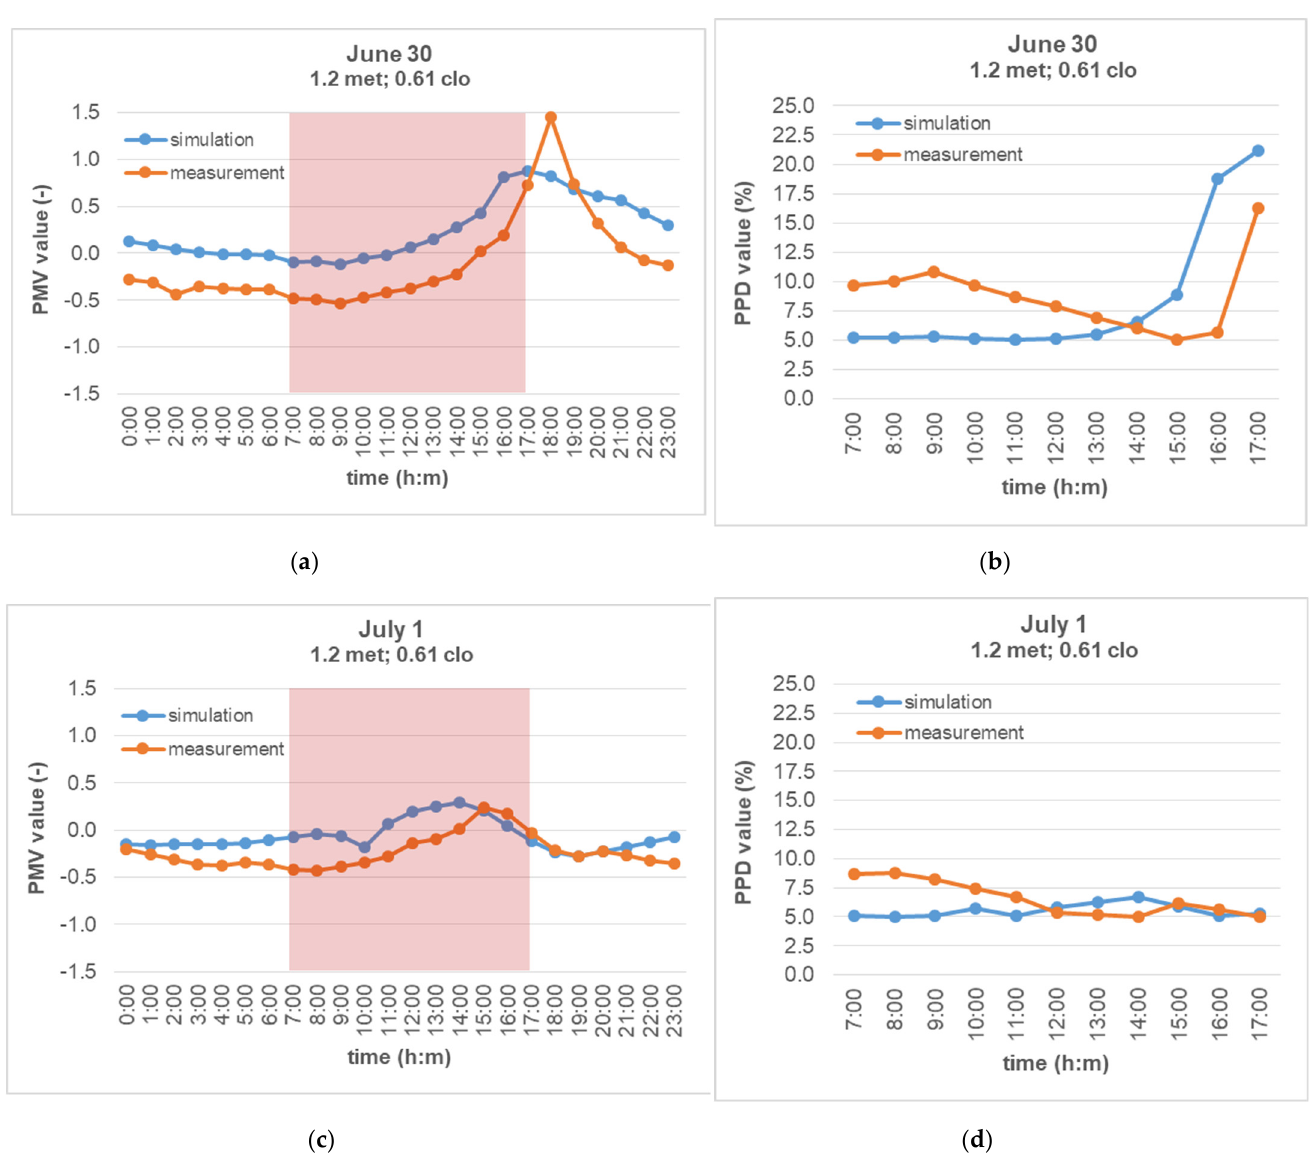
Figure 15. Evaluation of PMV and PPD indices using typical values of metabolism (1.2 met) and clothing resistance (0.61 clo): ( a ) PMV on 30 June, ( b ) PPD on 30 June, ( c ) PMV on 1 July, ( d ) PPD on 1 July.